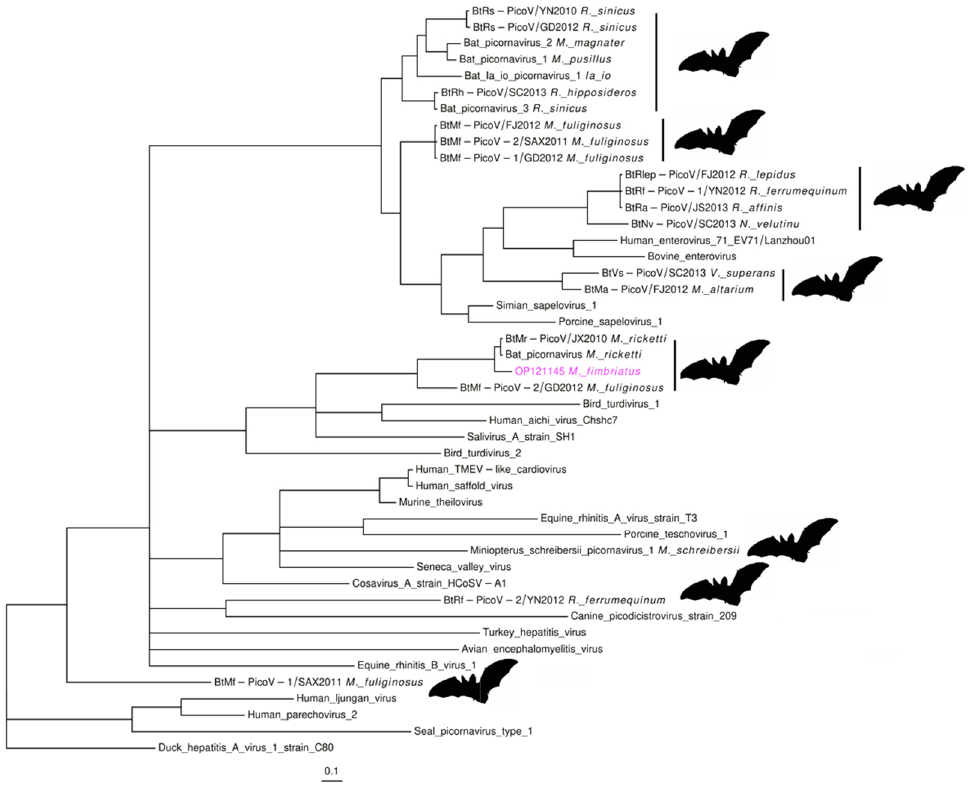
Figure 5. Picornavirus. Phylogenetic tree of an 84 a.a region of the peptidase C3 protein. The tree was derived under an LG + I + G model.